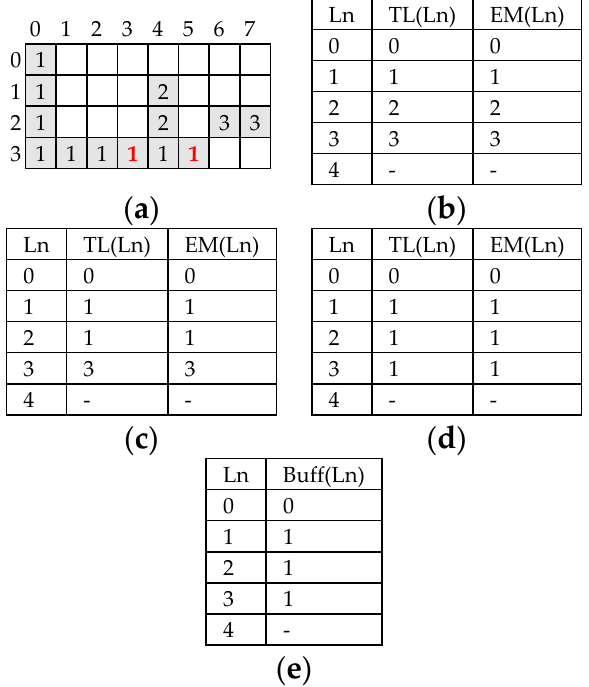
Figure 4. Example of CCL: ( a ) the input binary image; ( b ) content of TL and EM when P (3,3) is reached; ( c ) content of TL and EM when P (3,5) is reached; ( d ) content of TL and EM at the end of provisional labeling; ( e ) content of BUFF.